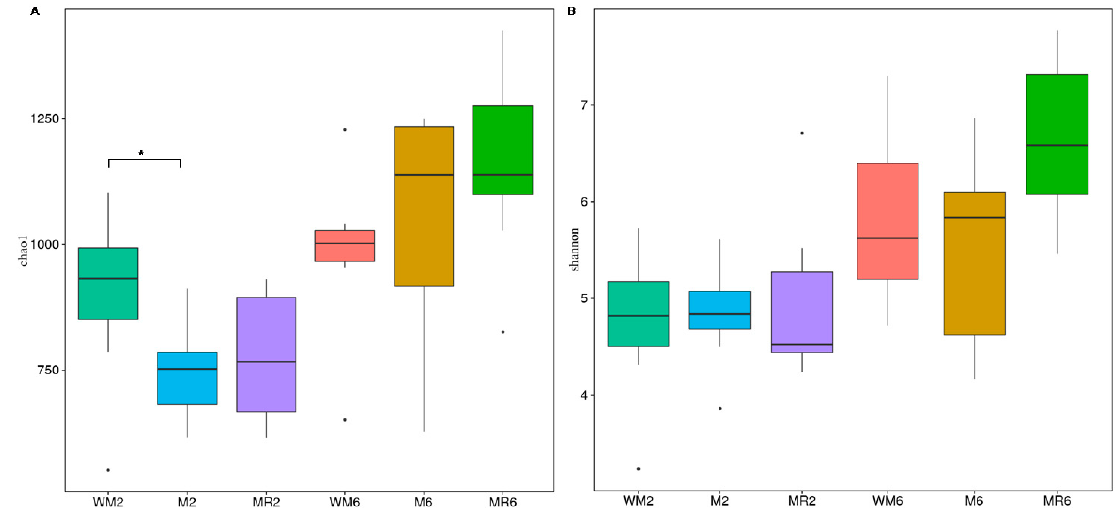
Figure 4. Alpha-diversity measures indicated by the ( A ) Chao1 richness estimator and ( B ) Shannon diversity. The horizontal lines within boxes represent the median, and the tops and bottoms of the boxes represent 75th and 25th quartiles, respectively. Outliers are plotted as individual points. *Significant difference was detected between treatment groups at p < 0.05 according to a t -test. WM2, M2 and MR2: rumen liquid was sampled at the age of two months from calves fed waste milk, milk and milk replacer, respectively. WM6, M6, and MR6: rumen liquid was sampled at the age of six months from calves fed waste milk, milk, and milk replacer, respectively.